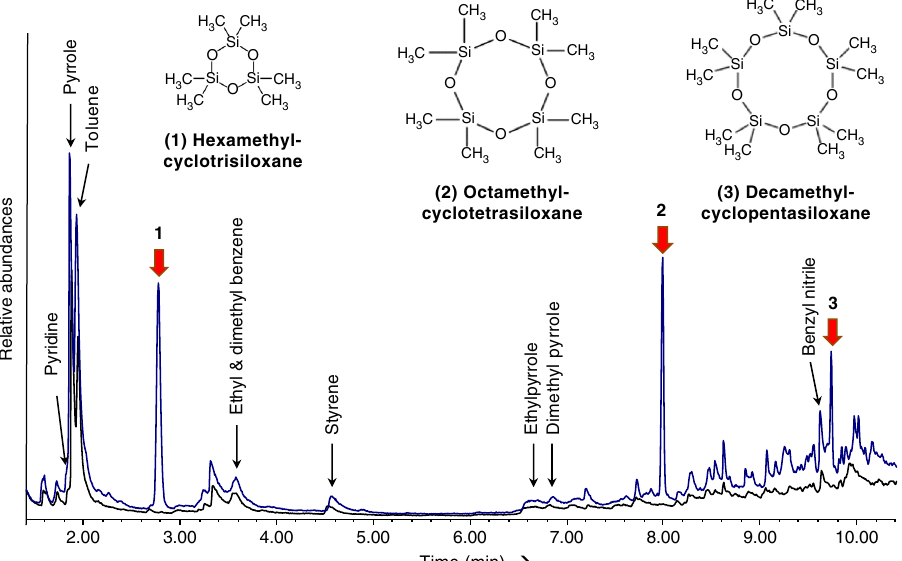
Fig. 4 Py-GC/MS characterization. Blue pro fi le — Pyrogram obtained on 450 µ g of the Salkhit bone; Black pro fi le — Pyrogram obtained on 220 µ g of an uncontaminated bone (Latton, UK) used as a standard at the ORAU. The main compounds identi fi ed in both pro fi les are pyrolytic products of collagen 51,52 . The pro fi le of the Salkhit sample also shows the presence of 3 compounds with siloxane structure (red arrows) that are reported as pyrolysis products of silicone 53 leading to assess the residual presence of such material within the bone matrix